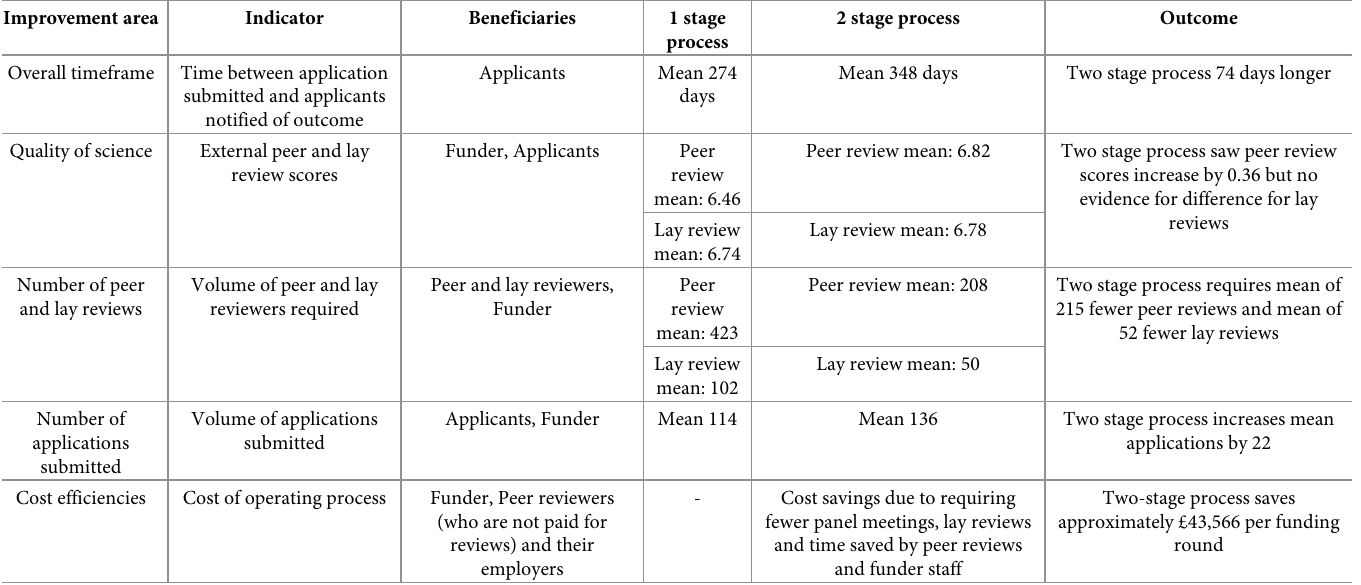
Table 5. Summary of advantages and disadvantages of two-stage